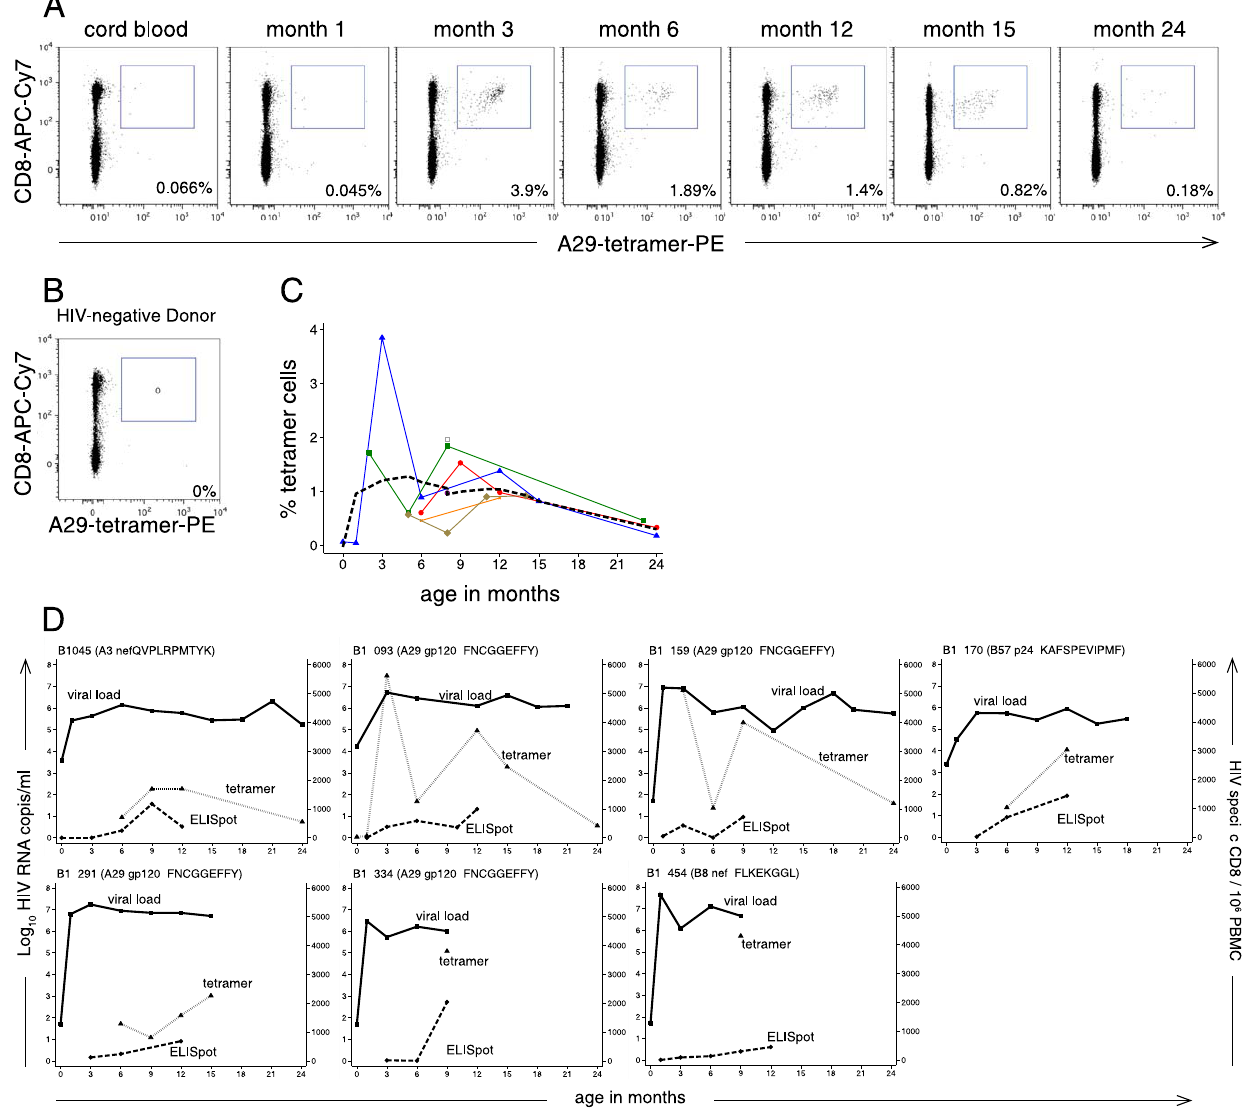
Figure 1. Tetramer-staining reveals the expansion of HIV-1 specific CD8 T cells during acute infant HIV-1 infection. A) Representative HLA-A29 GP120 tetramer staining from B1-093, who acquired HIV-1 in utero . Plots show cells gated on CD3 + lymphocytes. Frequencies of tetramer- positive cells are provided as a percent of CD3 + CD8 + gated cells. B) Tetramer staining from a negative control donor. C) Frequency of tetramer- positive cells, expressed as a percentage of the CD3 + CD8 + subset. Colored lines and markers show individual infants, bold dashed line shows a median spline. D) HIV-1 RNA viral load (solid line with squares, left y-axis), ELISPOT HIVSFU/million PBMC (dashed line with circles, right y-axis), and Tetramer + /10 6 PBMC (HIV-specific CD8 + T cells, dotted line with triangles, right y-axis) are shown for each of the 7 infants. Note, ELISPOT assays were conducted during live cohort follow-up for 1 year, viral load was measured at each study visit over 2 years of follow-up, tetramer staining was performed on all available frozen specimens. Missing values at visits indicate missed visit or specimen not available for assay. infected with HIV-1 in utero . Though the overall CD8 + T cell subset was a homogenous mixture of CD27 + CD28 + (early), CD27 + CD28 2 (intermediate) and CD27 2 CD28 2 (late) differentiated cells, HIV- specific CD8 + T cells were predominantly CD27 + CD28 2 (Figure 2A). A subset of CD3 + CD8 + expressed both CD45RA and CD57, suggesting the generation of terminally differentiated effector cells (Figure 2B). Consistent with their role as effector cells, CD45RA + CD57 + cells expressed high levels of HLA-DR, indicative of activation (data not shown). Both the overall CD8 + and HIV- specific CD8 + T cell subsets contained high frequencies of HLA- DR + (Figure 2C) and CD95 + cells (Figure 2D).